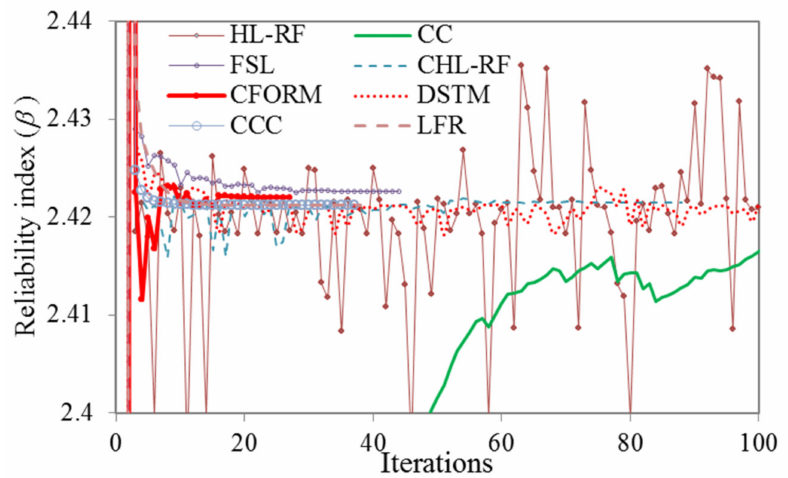
Figure 4. Iterative histories of HL-RF, FSL, CC, DSTM, CCC, LFR, CFORM, and CHL-RF in solving Example 2.